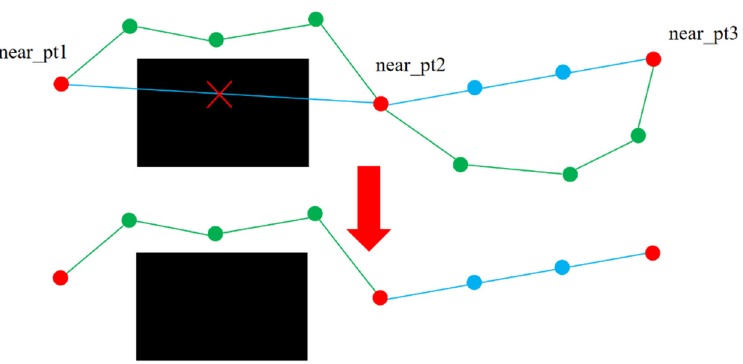
Figure 8. Schematic illustration of the process of path fine-tuning. point 1, point 2, point 3 are the intersection points of path fusion. Since the connection between point 1 and point 2 collides with obstacles, the original path is retained. In contrast, the connection between point 2 and point 3 is unobstructed so that the original path can be replaced by a new straight path.